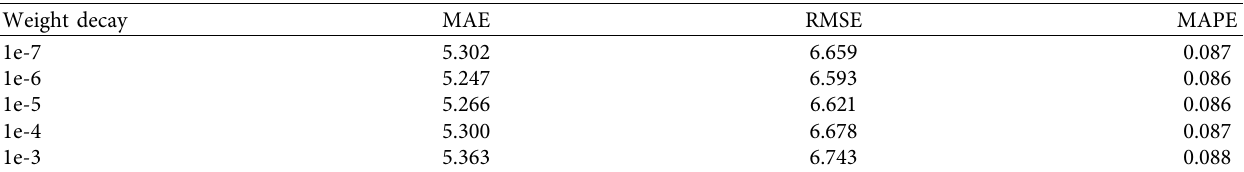
Table 5: The performance of AGBO with different values of weight